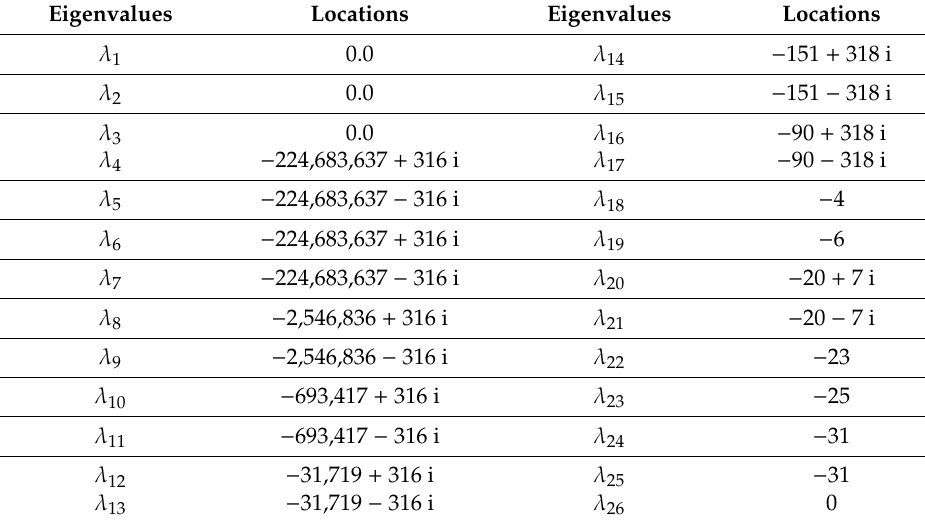
Table 4. The eigenvalues of the microgrid system.